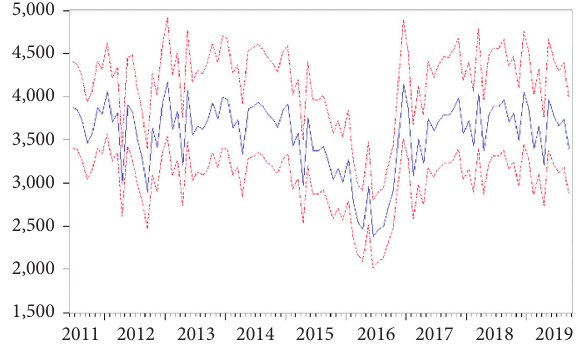
Figure 7: Prediction result of the SARIMA ( 4 , 1 , 2 )( 1 , 1 , 1 ) 12 model in the sample period.